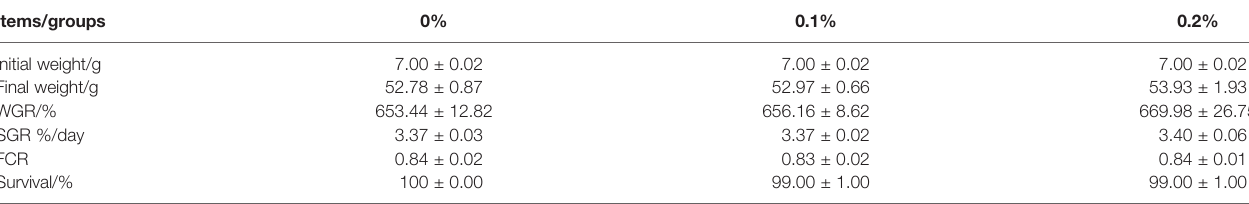
TABLE 3 | Growth performance, feed ef fi ciency, and survival rate of largemouth bass fed different experimental diets for 60